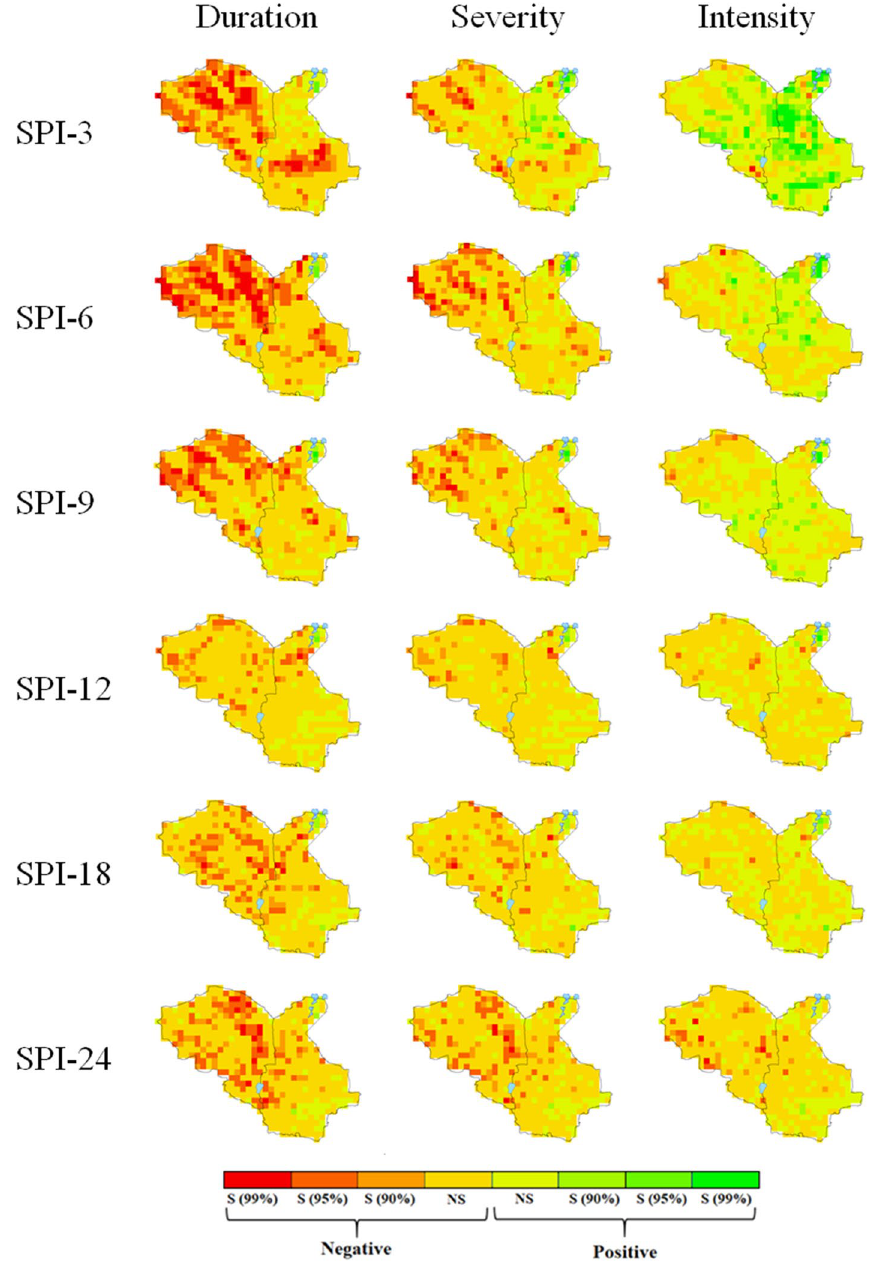
Fig. 8 Trends in DD, DS, and